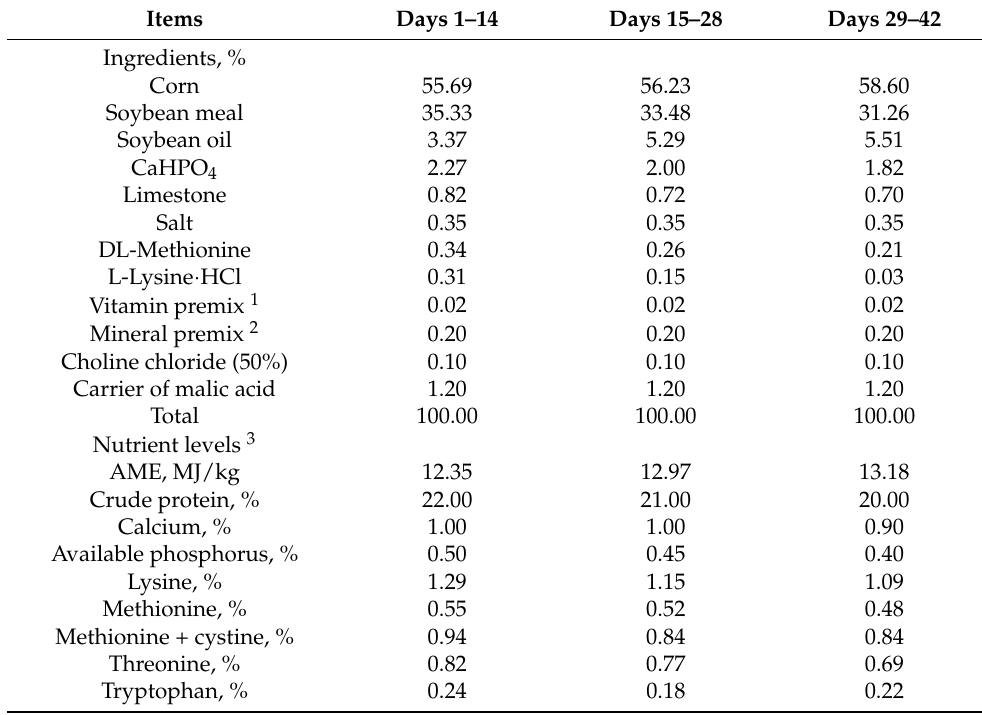
Table 1. Ingredient and calculated nutrient compositions of basal